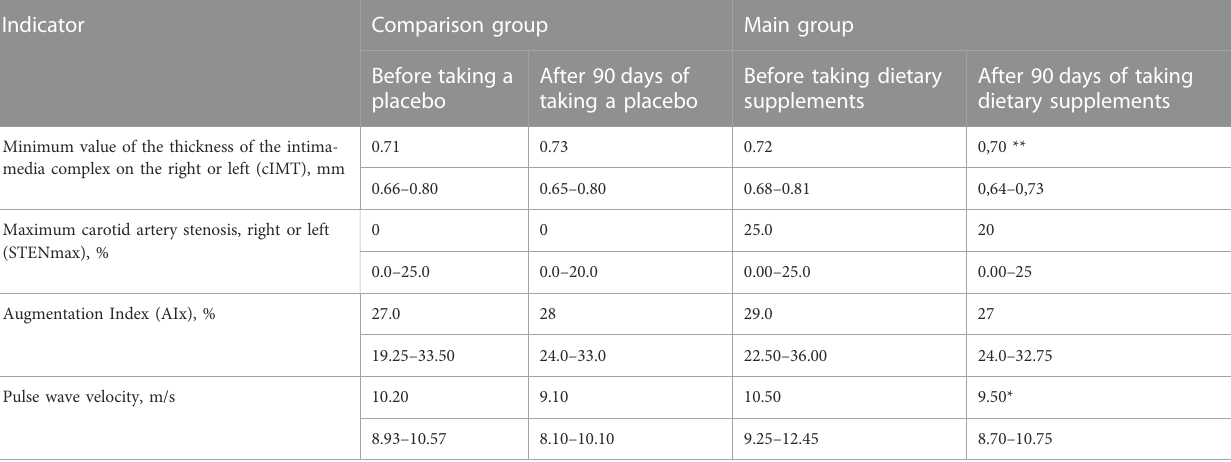
TABLE 2 Results of ultrasound of carotid arteries and applanation tonometry.